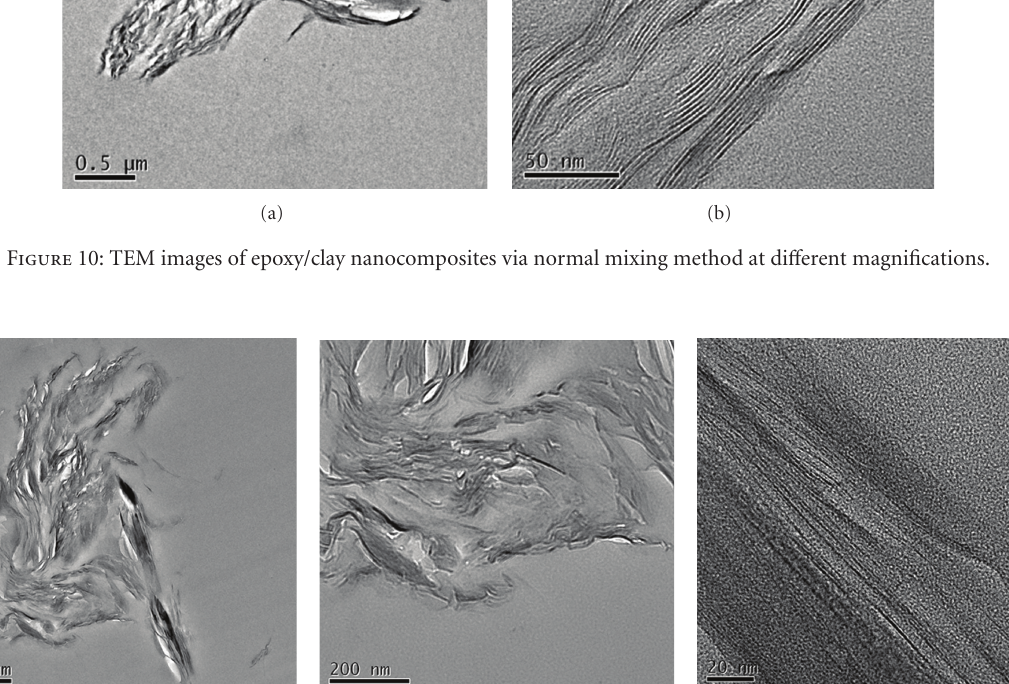
Figure 9. The penetration depth obtained from EDS